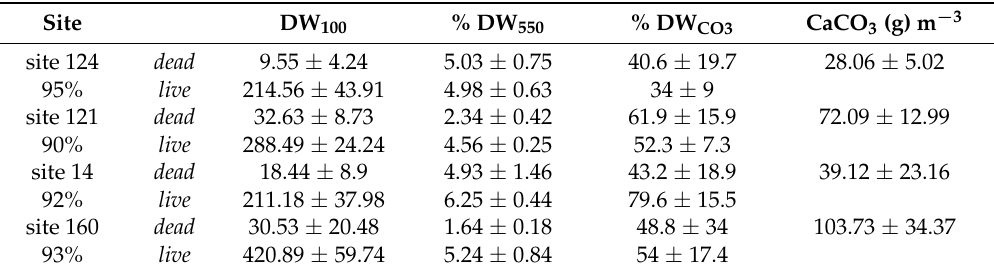
Table 5. Rhodolith attributes from benthic grabs at the four sites surveyed in the Nuuk region including average DW 100 (dry weight) of live and dead rhodoliths, with % live individuals indicated under site name, the average organic content in live and dead rhodoliths (% DW 550 ), and the average carbonate content in live and dead rhodoliths (% DW CaCO3 ). A calculation of total CaCO 3 m − 2 in rhodolith beds all values ±